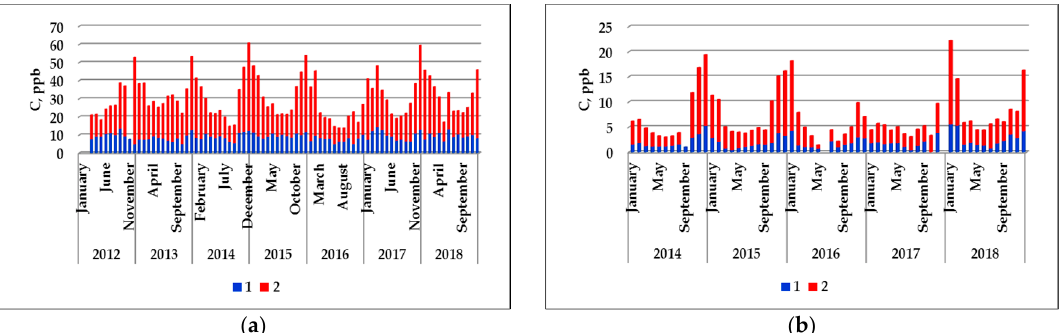
Figure 7. Long-term nitrogen oxide dynamics at the Irkutsk ( a ) and Listvyanka ( b ) sites. 1—NO 2 ; 2—NO, obtained using the passive sampling method.